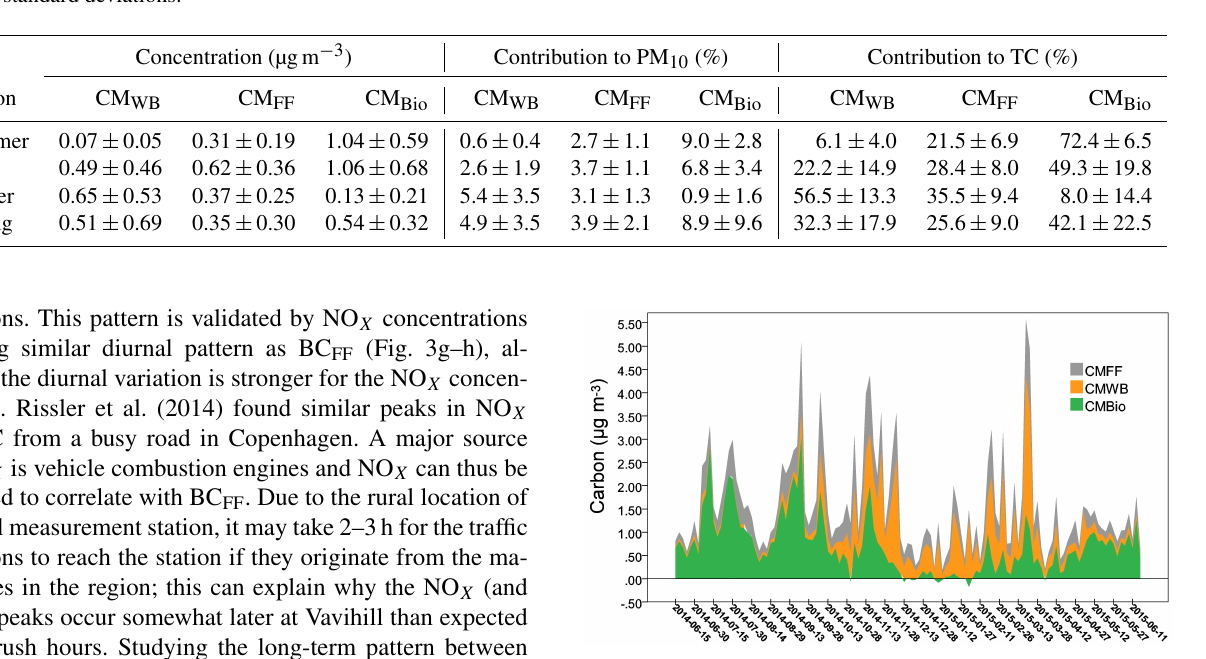
Table 4. Seasonal mean concentrations and contributions to PM 10 and TC of Aethalometer-model-derived parameters. Uncertainties are given in standard deviations.